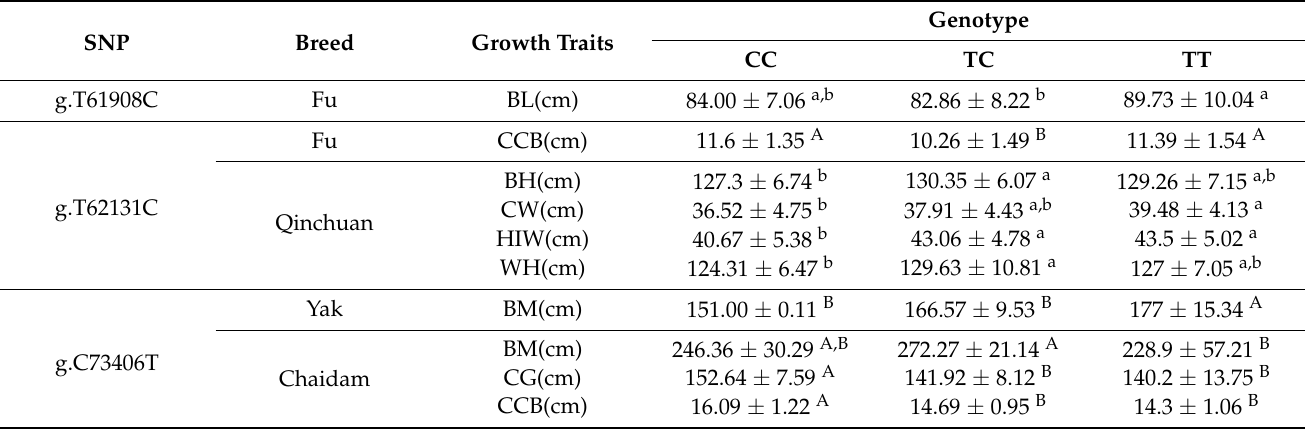
Table 3. Association analysis of three SNPs of the KAT2B gene and body measure traits. SNP Breed Growth Traits